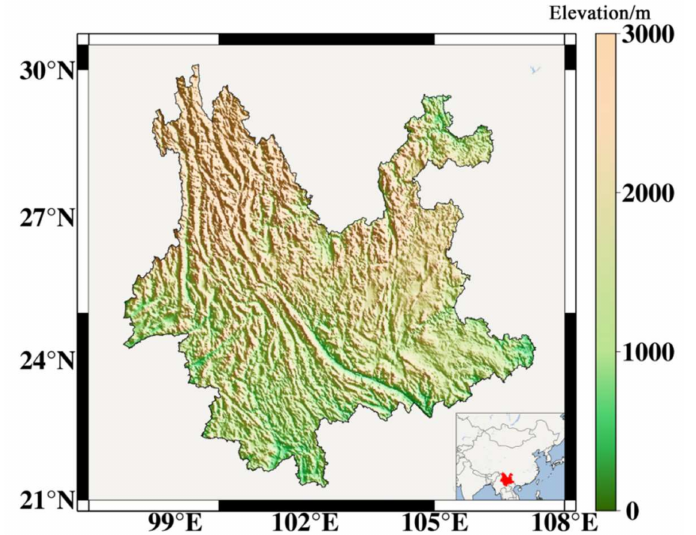
Figure 1. Digital elevation model of